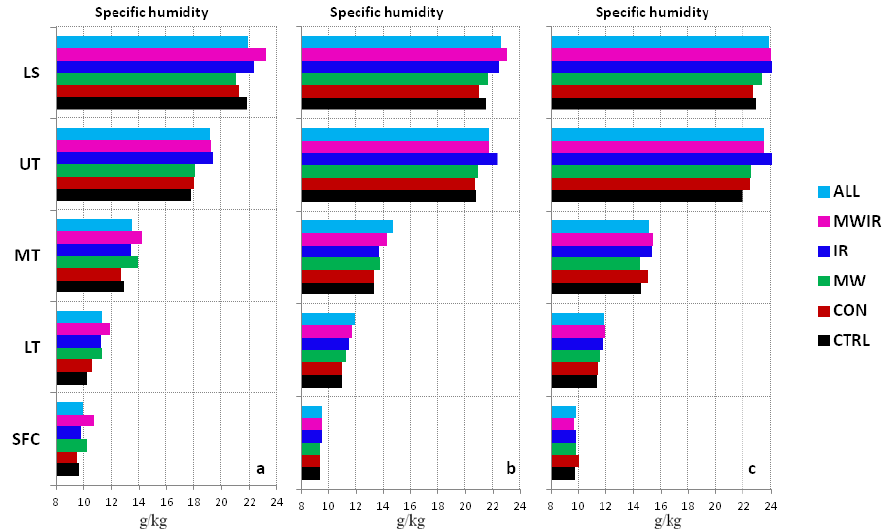
Figure 10. The RMSE profile of the specific humidity forecasts at (a) 6h , (b) 30h, (c) 54h forecasts. Unit: gkg − 1 . Other definitions are the same as in Fig.